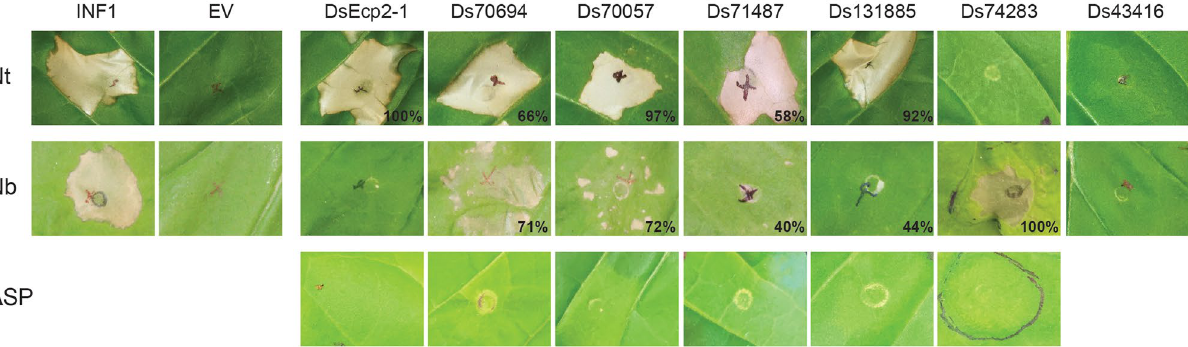
Figure 2. Dothistroma septosporum NZE10 candidate effectors (DsCEs) induce cell death responses in non-host plants. Genes encoding DsCEs, with a PR1α signal peptide for secretion to the plant apoplast, were introduced into Nicotiana tabacum (Nt; top row of images) and N. benthamiana (Nb; middle row of images) by agro- infiltration. Cell death responses were observed at 6 days post-infiltration. Representative images are shown, along with the percentages of all infiltrations where cell death occurred (n = 12–24 infiltration zones, from at least three independent experiments). Ds43416 is included as a representative of DsCEs that did not elicit a cell death response in either of the plant species tested. The bottom row of images shows the results of agro- infiltration of DsCE proteins lacking a PR1α signal peptide (ΔSP; no secretion into the apoplast) in N. tabacum (DsEcp2-1, Ds70694, Ds70057, Ds71487 and Ds131885) or N. benthamiana (Ds74283). INF1, Phytophthora infestans elicitin positive control; EV, empty vector negative